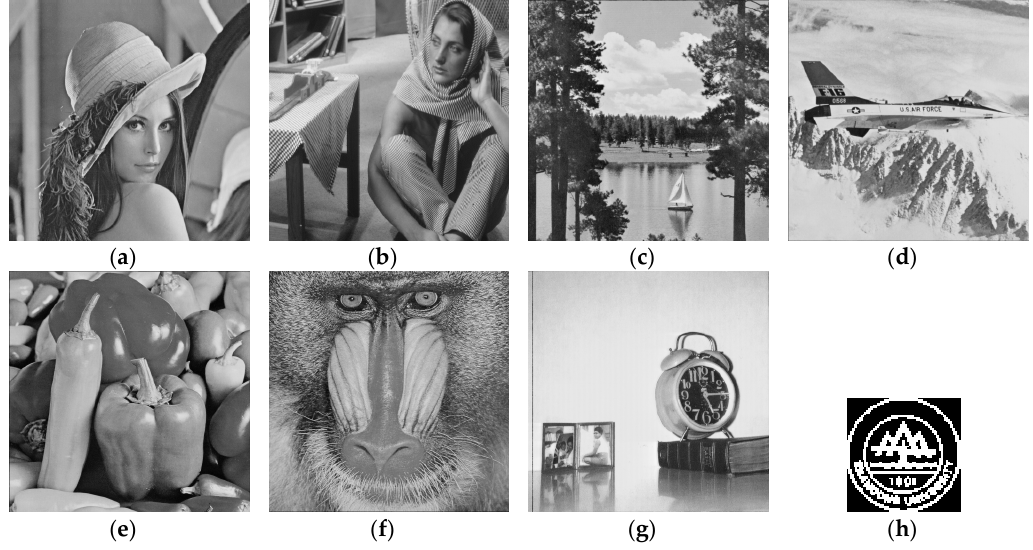
A w A Figure 3. Watermark embedding process. 4.2. Watermark Extraction